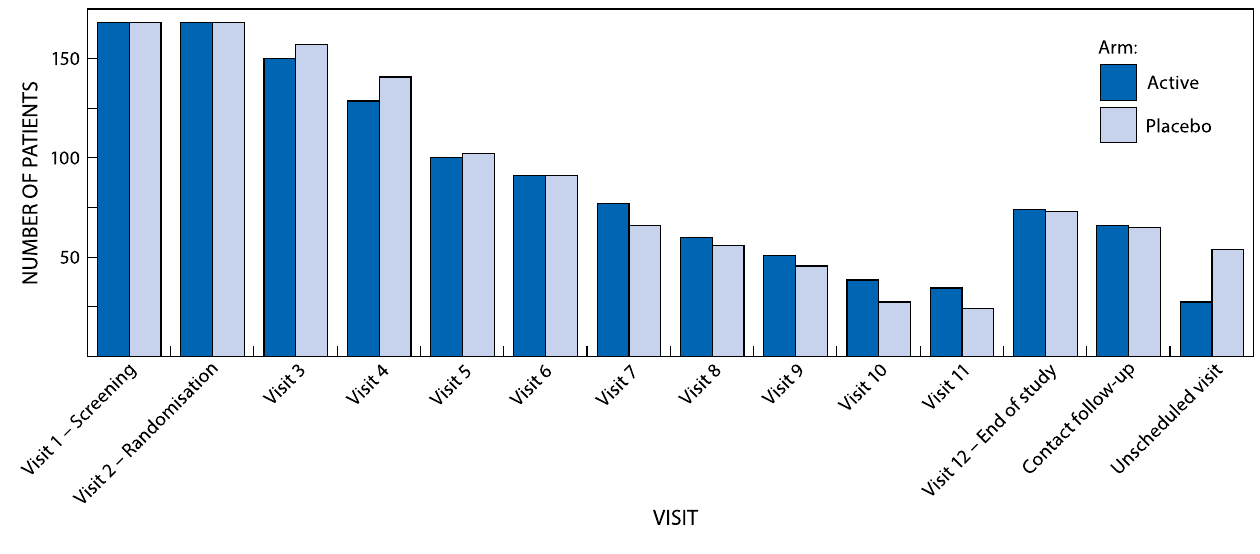
Figure 1: Total number of patients who went for each visit prior to study termination. Note: The study is highly censored after the 6th and 7th visits due to early termination of the study. The graph show patients per visit as some patients skipped some visits and others stopped before final visit or study completion. The report is however on all recruited patients (ITT analyses). Data is of patient who had at least two